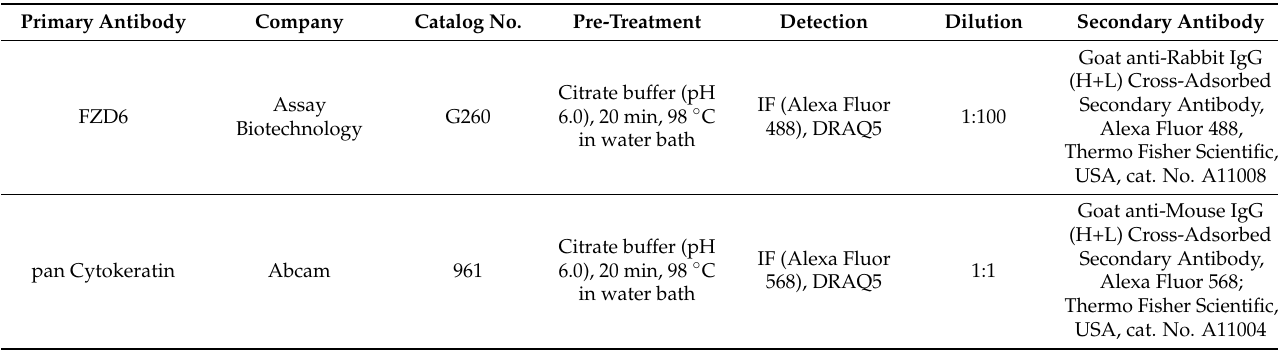
Table 2. List of primary and secondary antibodies used for immunofluorescence